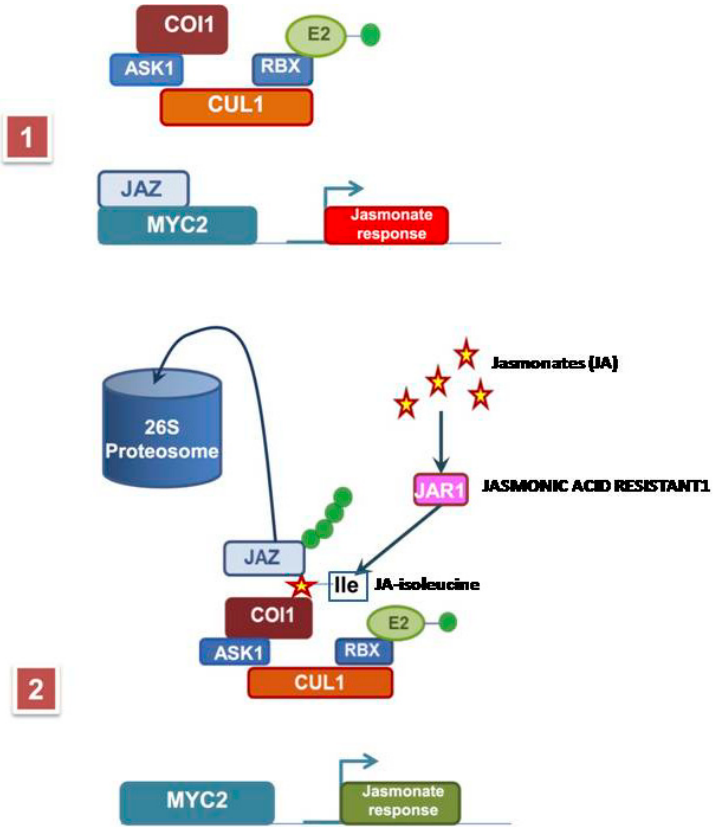
Figure 2. The F-box protein receptor for isoleucine jasmonate. ( 1 ) shows the F-box and the gene to be transcribed before jasmonate application; ( 2 ) shows the F-box binding the isoleucine jasmonate, the withdrawal of the JAZ protein from the promoter, the ubiquitination of the JAZ protein to be degraded in the proteosome, and the gene promoter free of the JAZ and ready to be transcribed by MYC2. ASK1, Apoptosis Signal-regulating Kinase 1; COI1, Arabidopsis coronatine-insensitive1; CUL1, component of the SCF complex; JAR1, Jasmonic Acid-Resistant 1; JAZ, Jasmonate ZIM-domainis a transcriptional regulator protein; MYC2, transcription factor; RBX, component of the SCF complex.